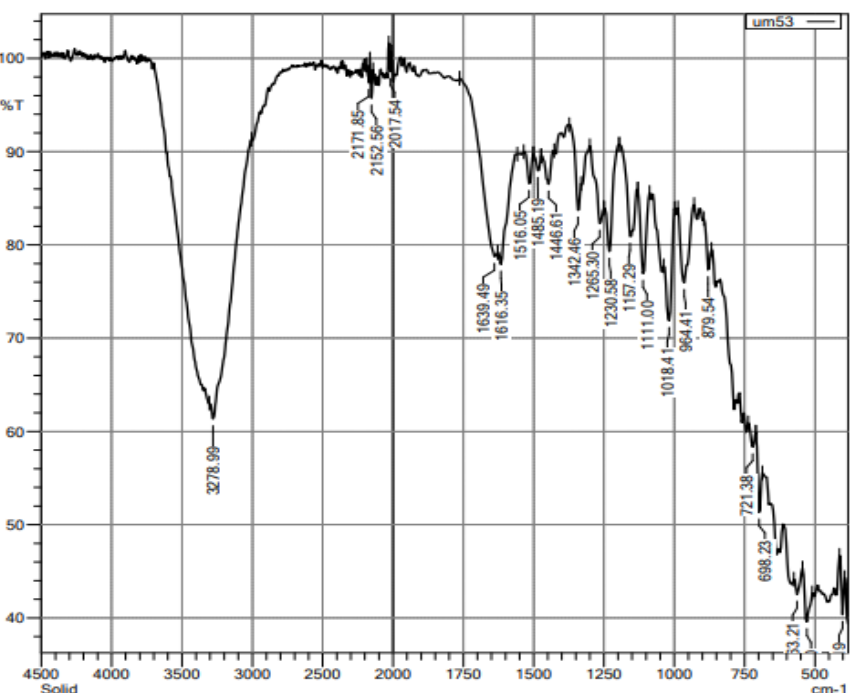
Figure 3. FTIR spectra of the aqueous extract of N. sativa seeds. The X-axis represents the wavenumber (cm − 1 ), and Y-axis represents the % transmittance.